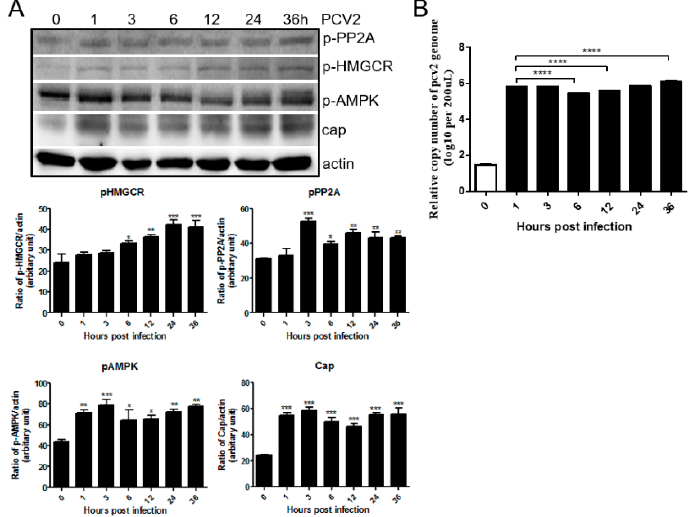
Figure 1. PCV2 infection increases phosphorylation of PP2A, AMPK and HMGCR. Cells were